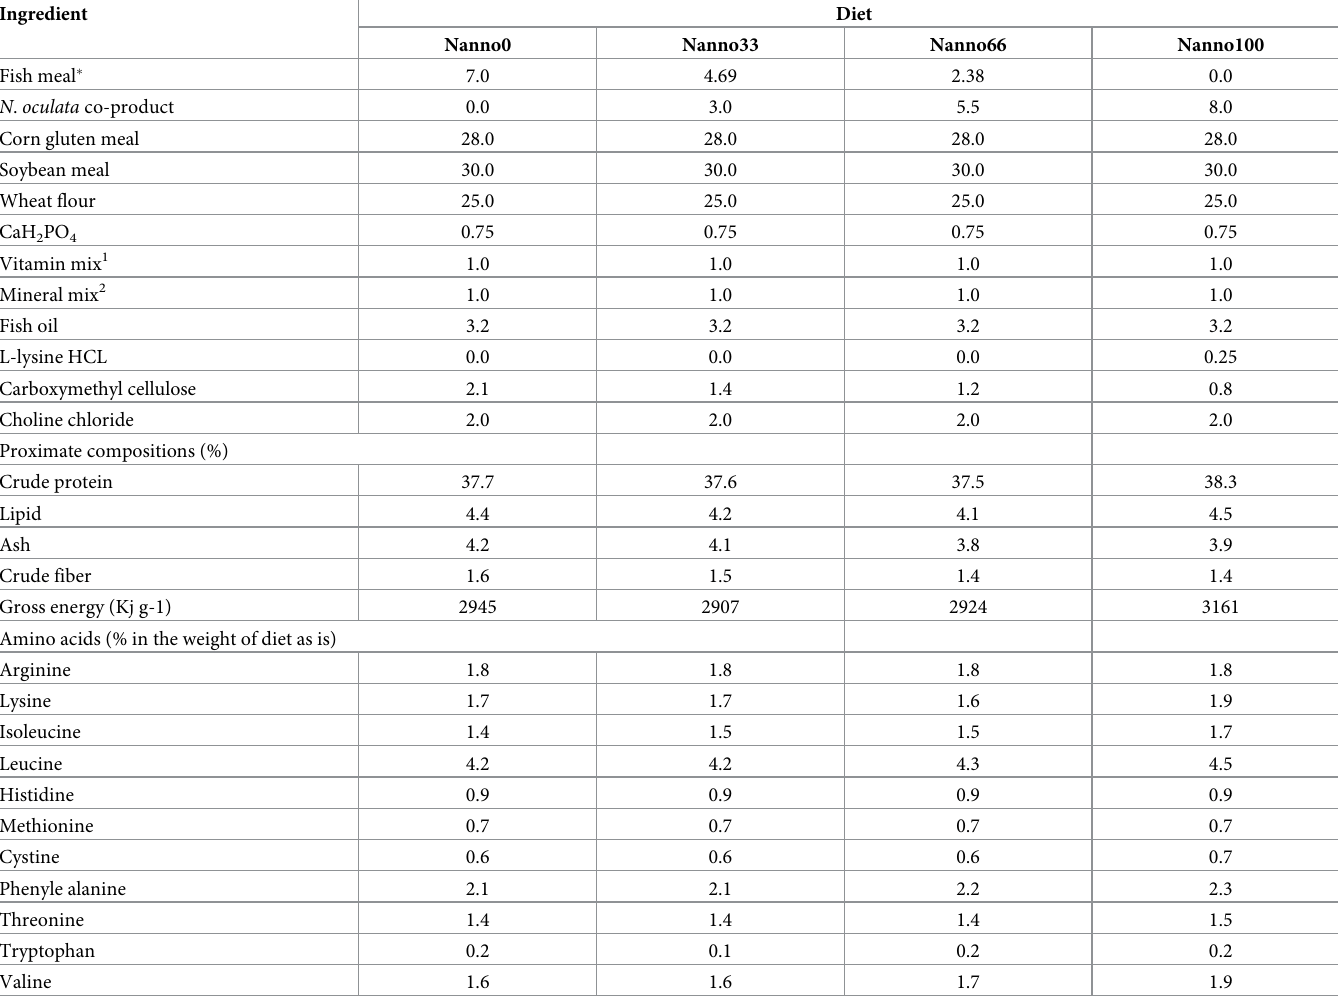
Table 6. Formulation (g/100g diet) and proximate composition (%) and essential amino acids (% in the weight of diet) of four experimental diets for juvenile tilapia.